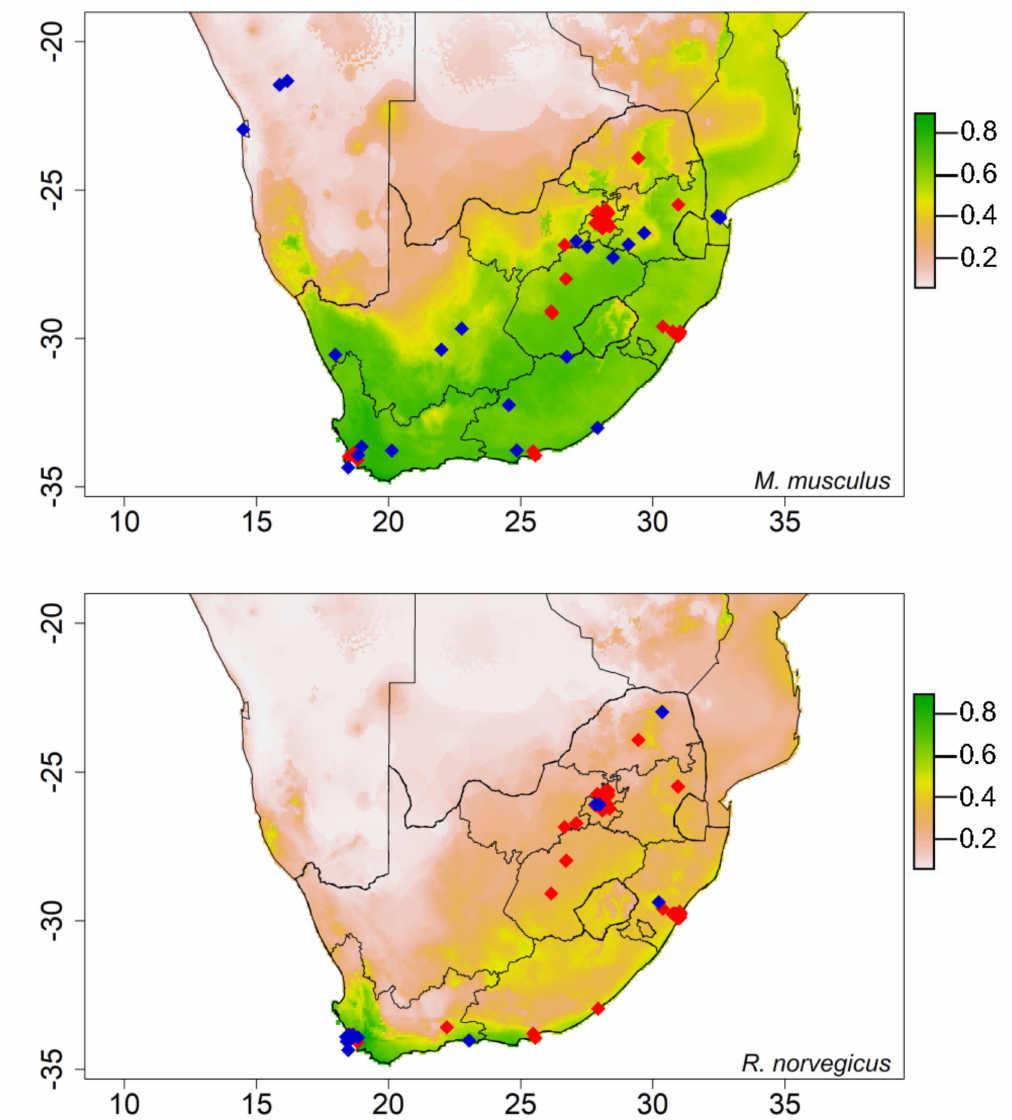
Figure A1. The potential distribution from ecological niche modeling of house mice ( Mus musculus ) and Norwegian rats ( Rattus norvegicus ) in South Africa (Note: The color ramp threshold on the right measured the suitability: green indicates the most suitable areas, decreasing to yellow and orange, with light gold and white being unsuitable). Blue dots indicate current distribution records and red dots indicate selling